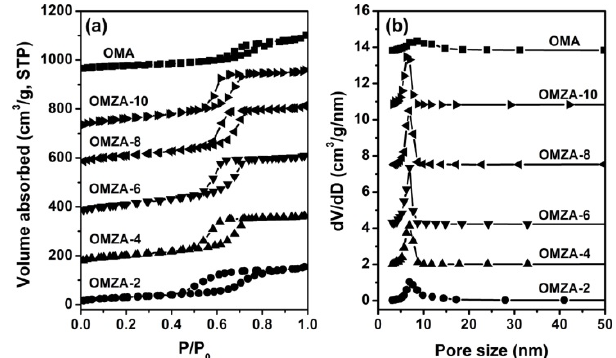
Figure 8. Small- ( a ) and wide- ( b ) angle XRD patterns of samples OMZA-x and OMA after thermal treatment at 1000 °C for 1 h.